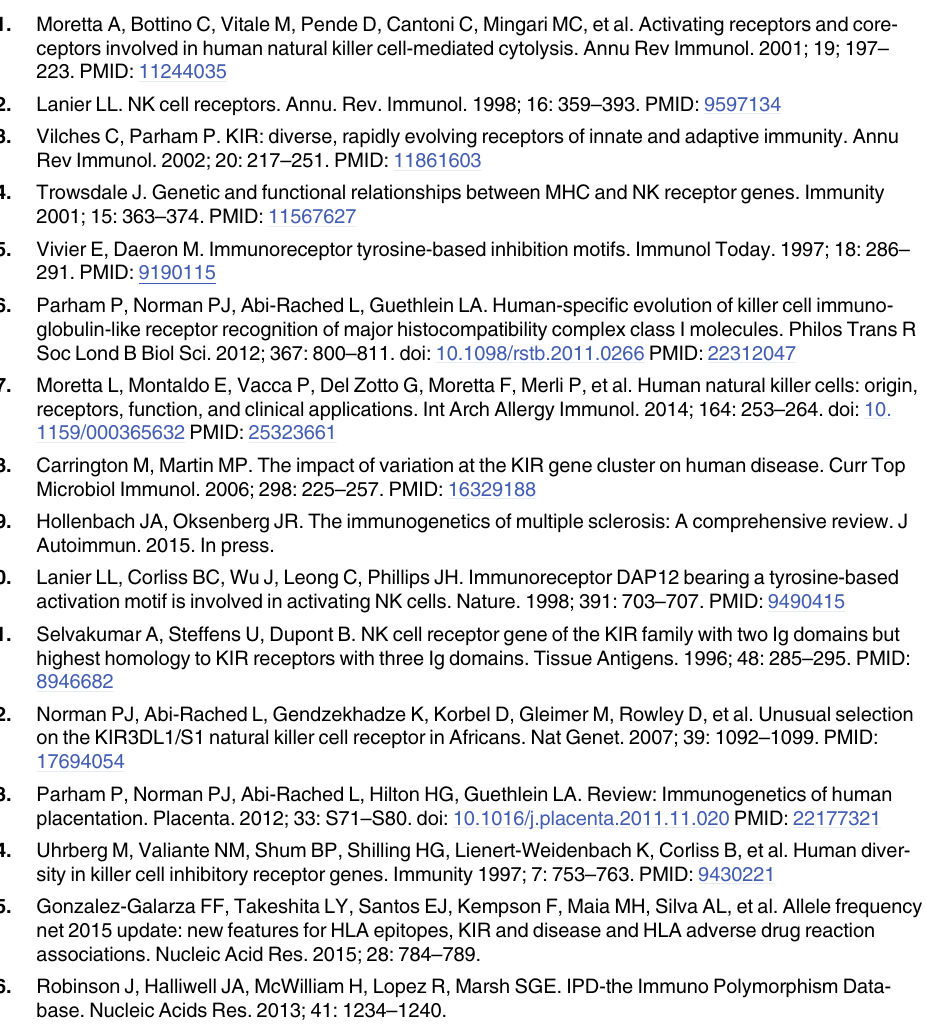
S5 Table. KIR estimated genes ( gF ) and haplotypes frequencies for global populations. The datasets were used to construct Figs 2 and 3. C.C = cannot be calculated; F = frequency, N. T = not